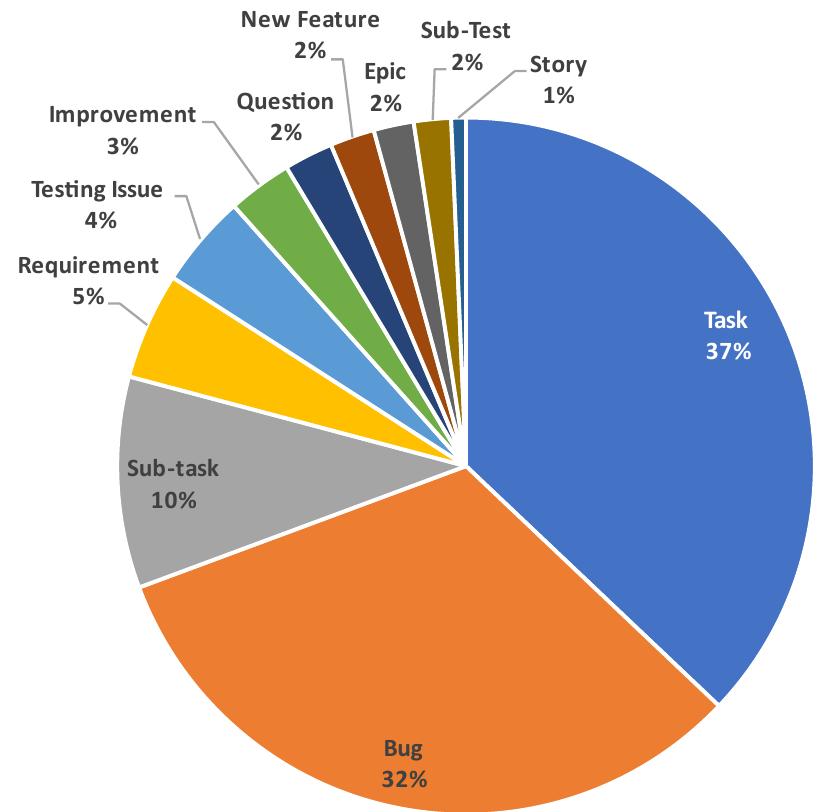
Figure 1. The occurrence frequencies of issue types in the researched projects.